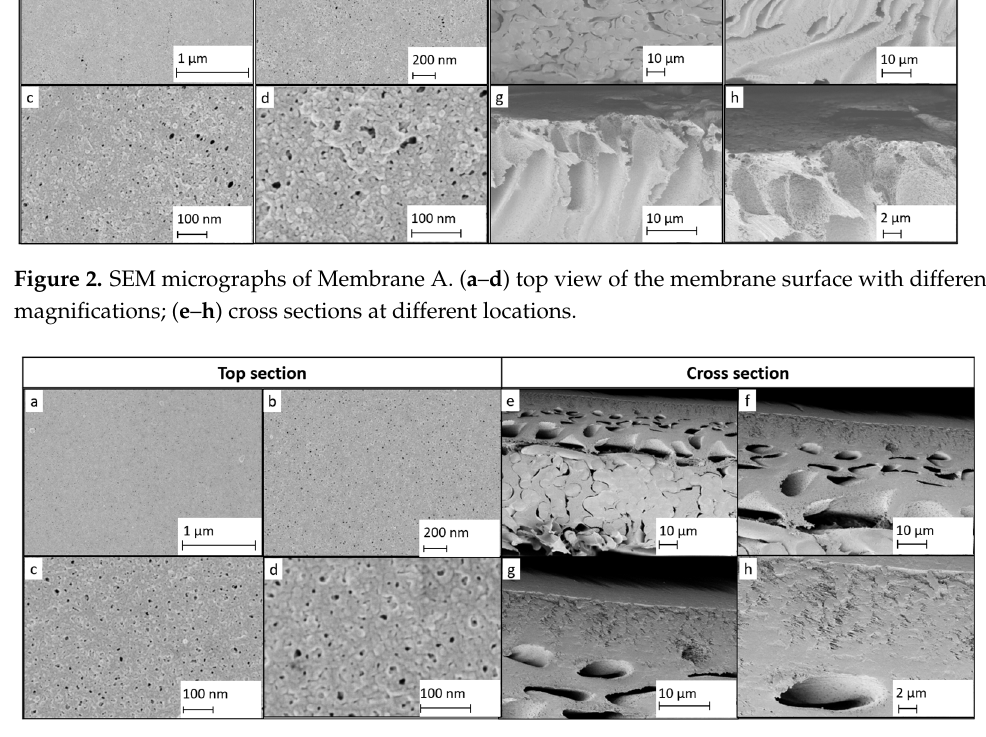
Figure 3. SEM micrographs of Membrane B. ( a – d ) top view of the membrane surface with different magnifications; ( e – h ) cross sections at different locations.